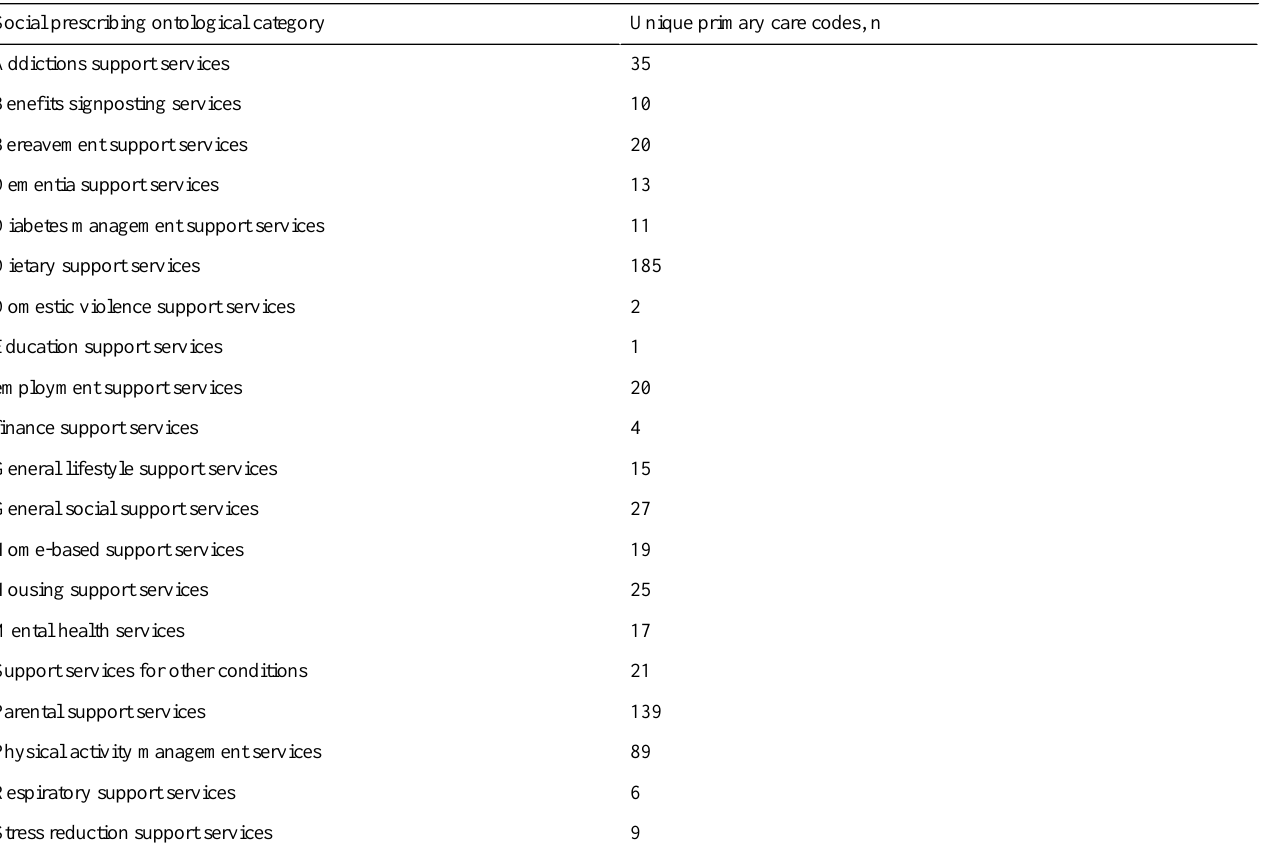
Unique primary care codes, nSocial prescribing ontological